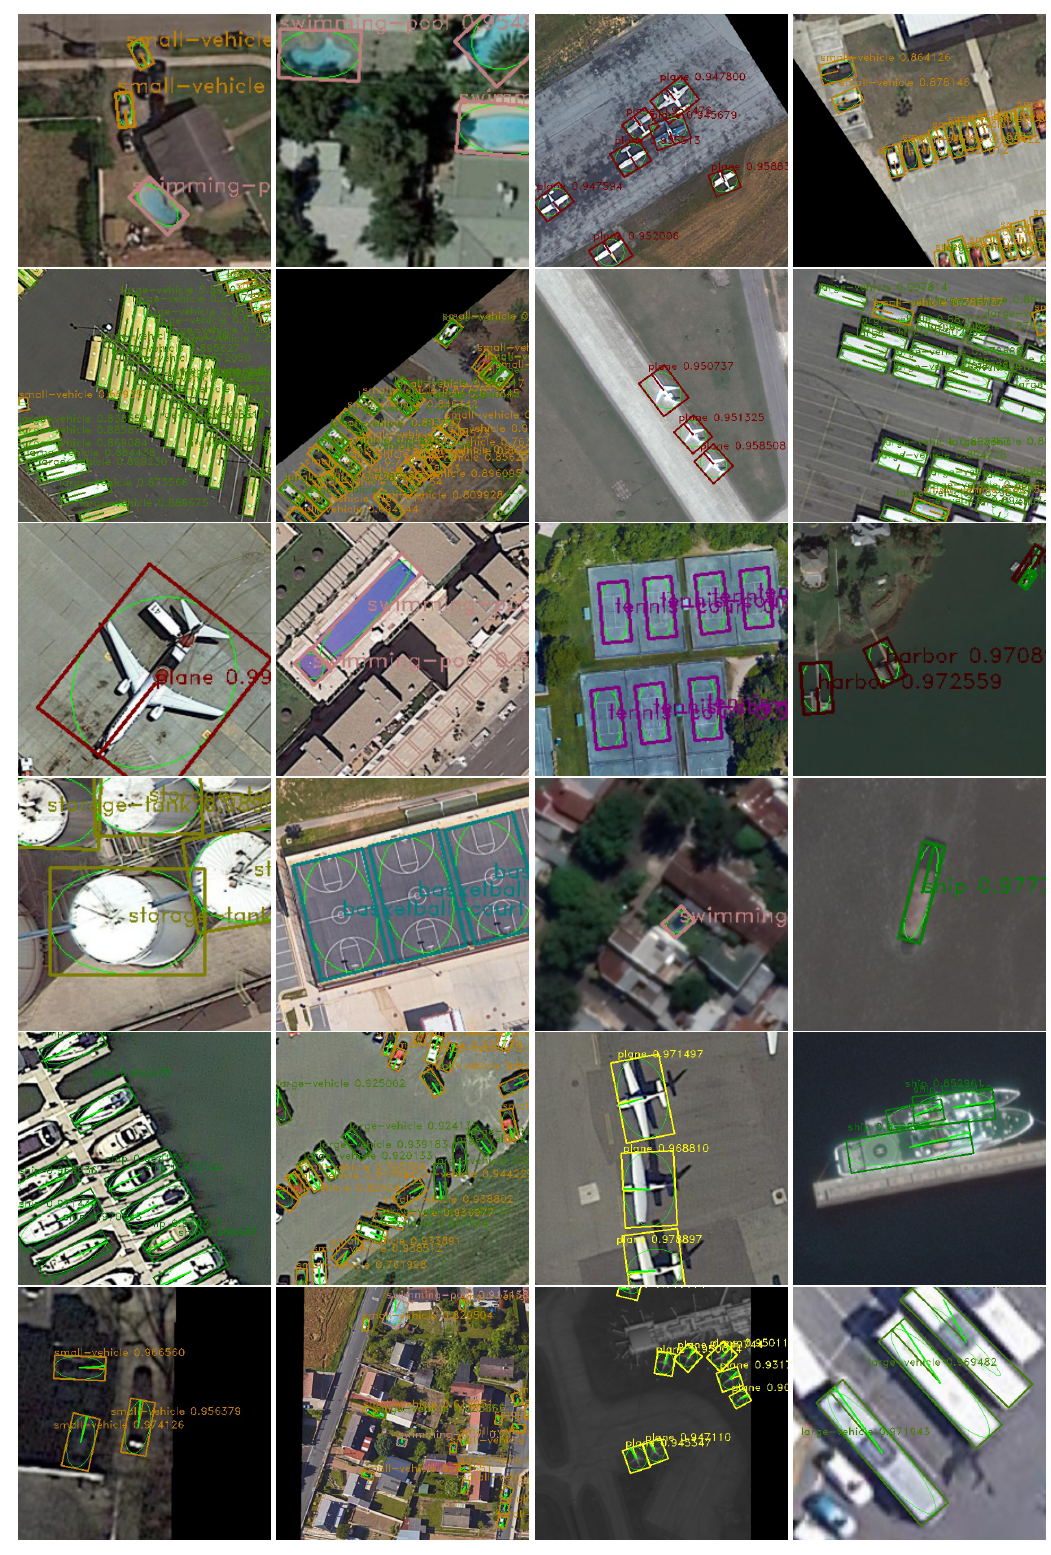
Figure 8. Visualizations of results on the DOTA dataset. The line segment starting from the object center point identifies the direction of the object. The category object marked with a main direction line in the area of the object oblique quadrilateral is the object type marked with * in Table